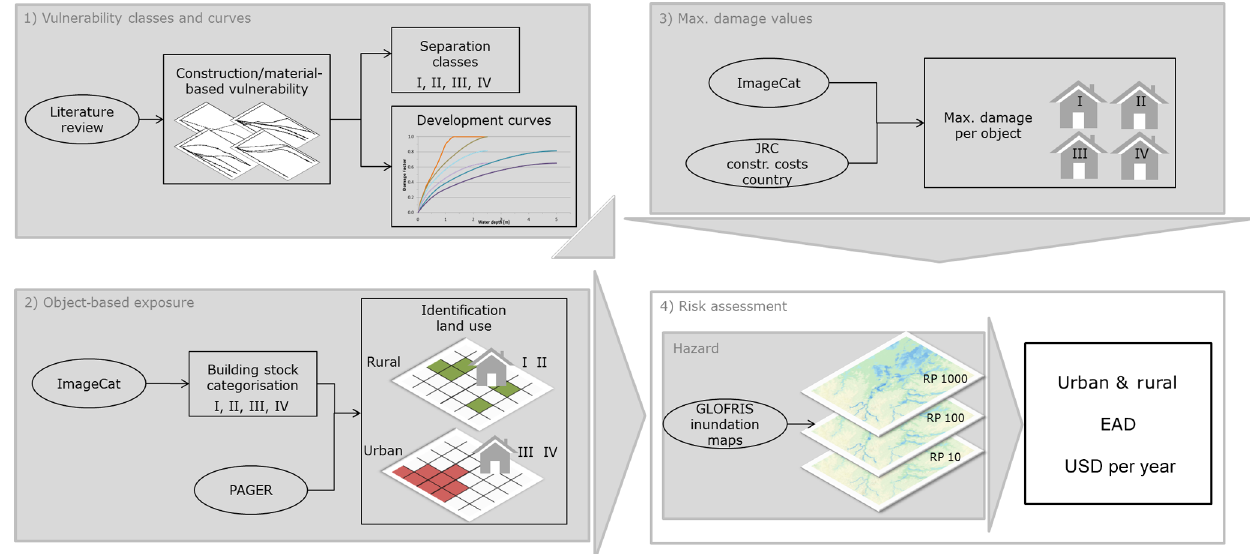
Figure 1. Flowchart for large-scale flood risk assessment using object-based data with a building-material-based vulnerability